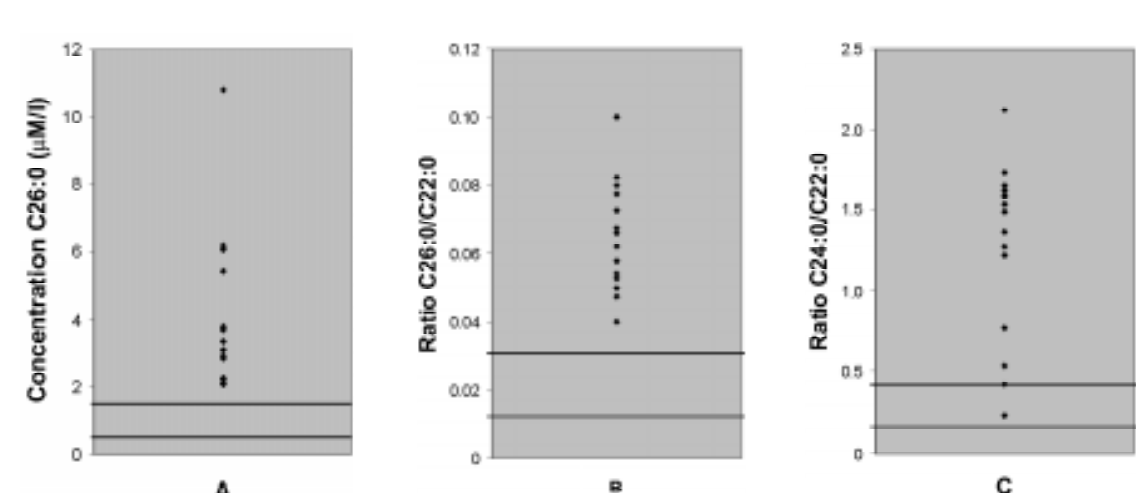
Figure 1 - Very long chain fatty acid levels in 15 Brazilian patients with X-linked adrenoleukodystrophy: A , C26:0 plasma concentration; B , C26:0/C22:0 ratio; C , C24:0/C22:0 ratio. The horizontal solid lines indicate upper (X + 2 SD) and lower (X - 2 SD) reference values, calculated with samples from 30 healthy subjects. SD = Standard